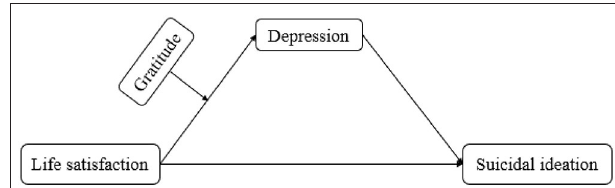
FIGURE 1 | The moderated mediation model.